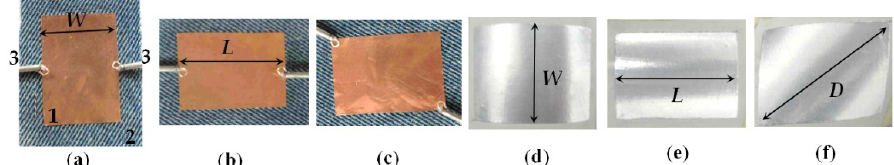
Figure 8. ( a – c ) Pair of magnetic coaxial loops placed on the length, width, and diagonal of the planar resonator; ( d – f ) length (L)-bent, width (W)-bent and diagonal (D)-bent microstrip resonators. Legend: 1—resonator; 2—substrate; 3—pair of magnetic coaxial probes.